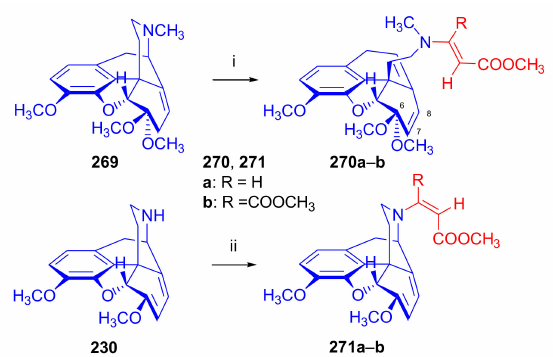
Figure 73. Reaction of neopinone dimethyl ketal and N 17 -northebaine with acetylenic dienophiles. Reagents and conditions : (i): MP or DMAD, acetonitrile, room temperature, 8–12 h, 48–53%; (ii): MP or DMAD, acetonitrile, room temperature, 30 min,